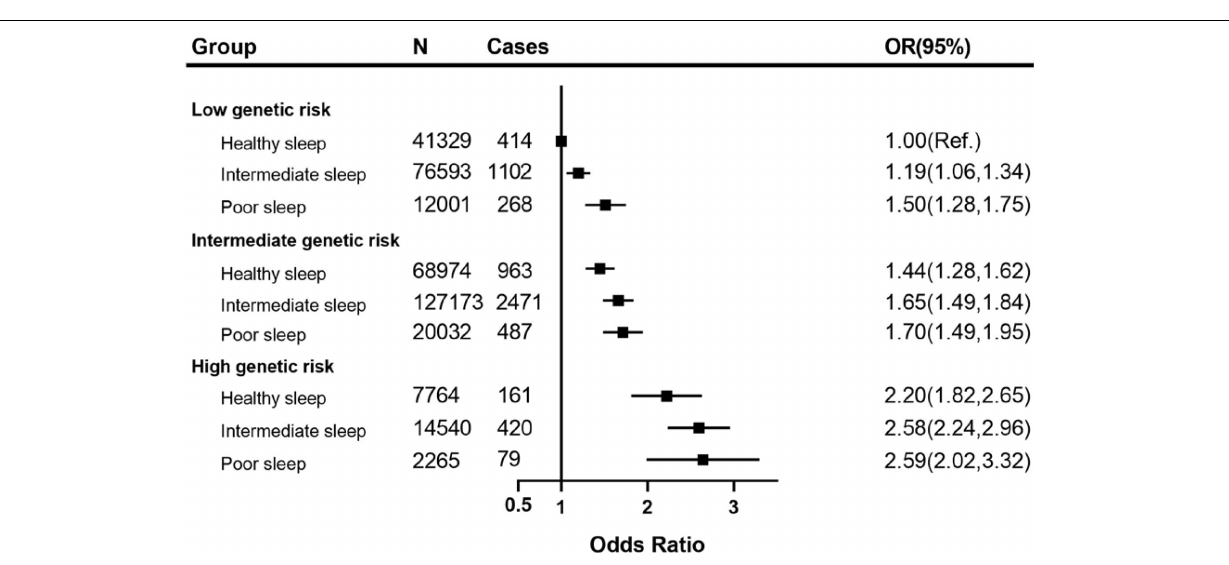
FIGURE 3 | The joint association of weighted genetic risk and sleep pattern with CKD among 370,671 European ancestry participants. The vertical line indicates the reference value of 1. Multivariable model was adjusted for age, sex, ethnicity (White/others), education (university or college degree/others) and the Townsend index (continuous), smoking status (current, ever, never), drinking status (drinks, continuous variable), physical activity (at goal or not), overweight and obesity (BMI ≥ 25 kg/m2), systolic blood pressure, diabetes (yes/no), use of blood pressure-lowering medications (yes/no) and use of diabetes medications (yes/no). CKD, chronic kidney disease; CI, confidence interval; OR, Odds